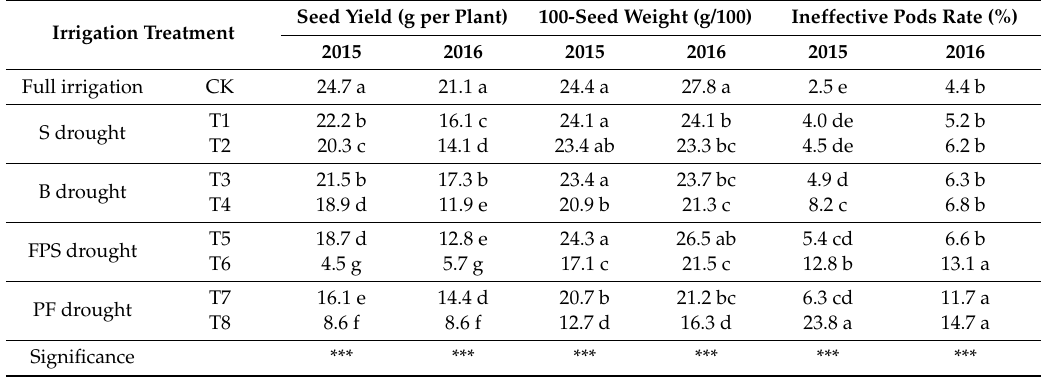
Table 4. Effects of water deficit at different stages on soybean yield and its